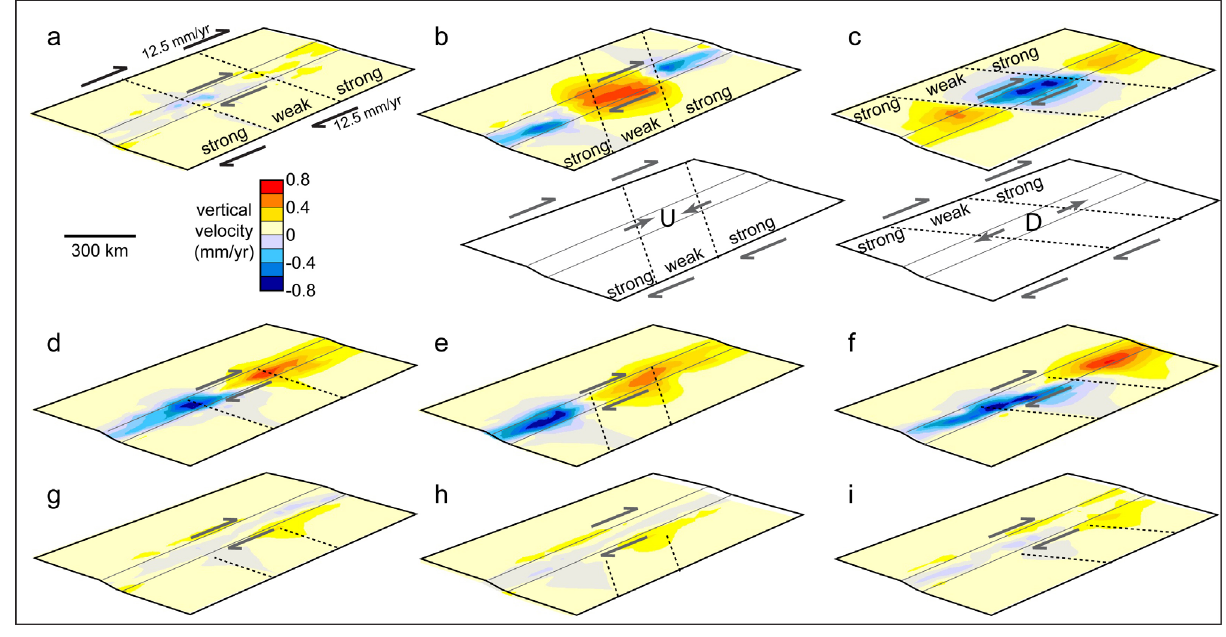
Figure 7. Maps of vertical velocities at the surface of the models for model with 100 km wide deforming zone; ( a ) Weak zone extends across the whole model orthogonal to the boundary but there is very little vertical displacement above weak zone because it is too narrow; ( b – f ) Model results similar to Figure 6(b–f); ( g – i ) Weak zone limited to east of deforming zone and hence there is very little vertical displacement in any of these